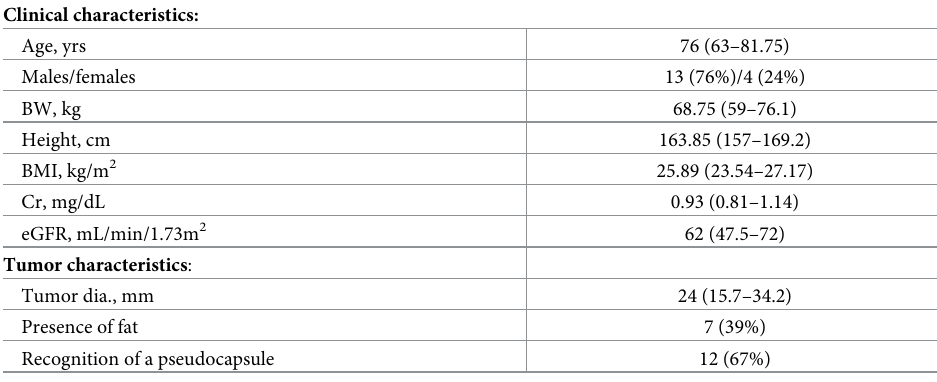
Table 1. The characteristics of the 17 patients with small renal cell carcinoma (small RCC). Clinical